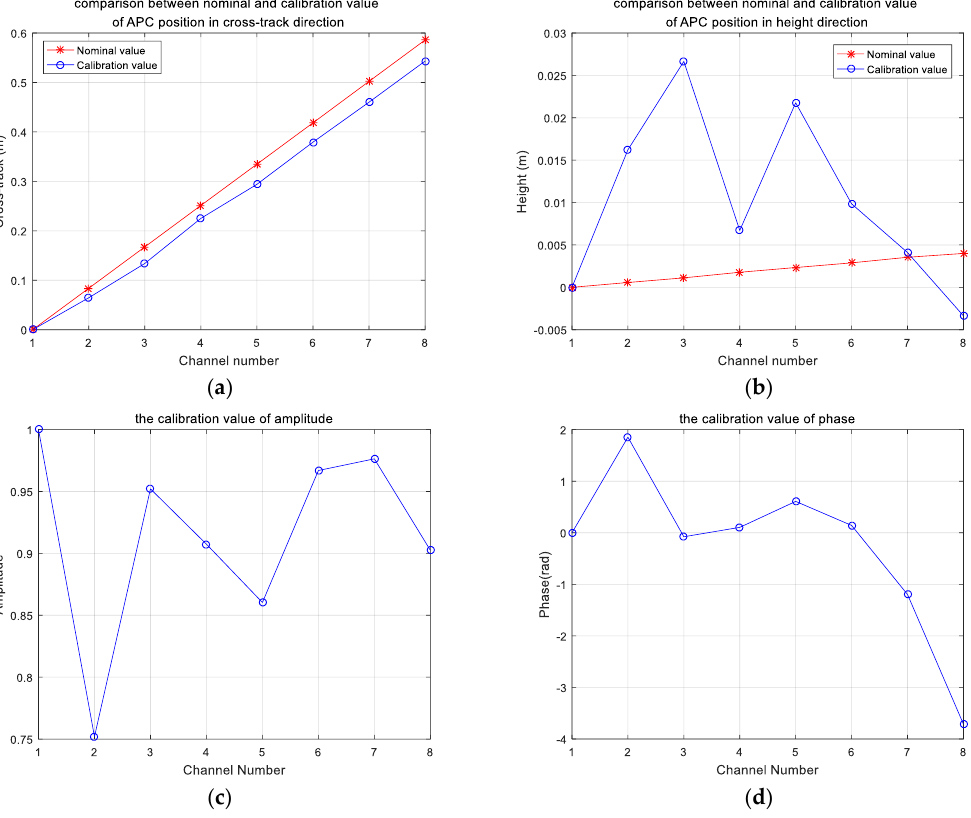
Figure 9. Calibration results of the real SAR data set. ( a ) The nominal and calibration values of axis x (cross-track direction). ( b ) The nominal and calibration values of axis z (height direction). ( c ) The calibration values of the amplitude. ( d ) The calibration values of the phase.